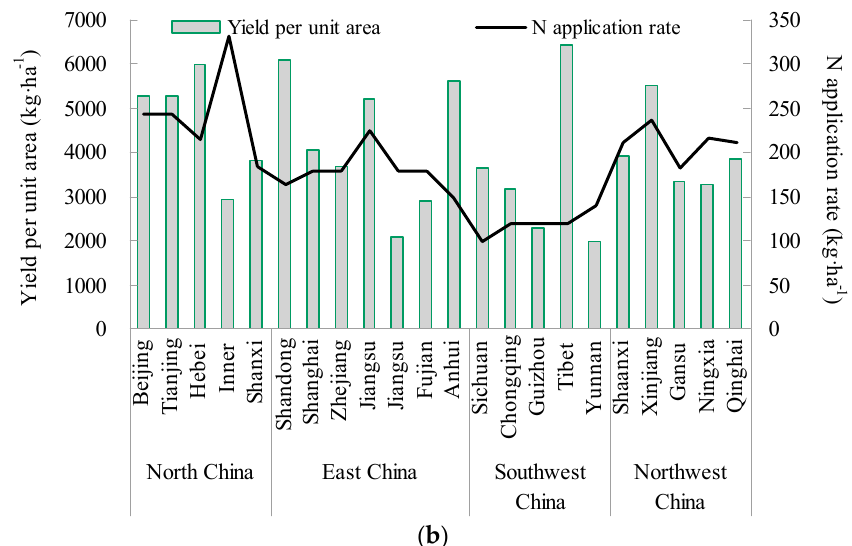
Figure 2. Nitrogen application rate, yield per unit area, and average value of wheat in each province from 2012 to 2016.